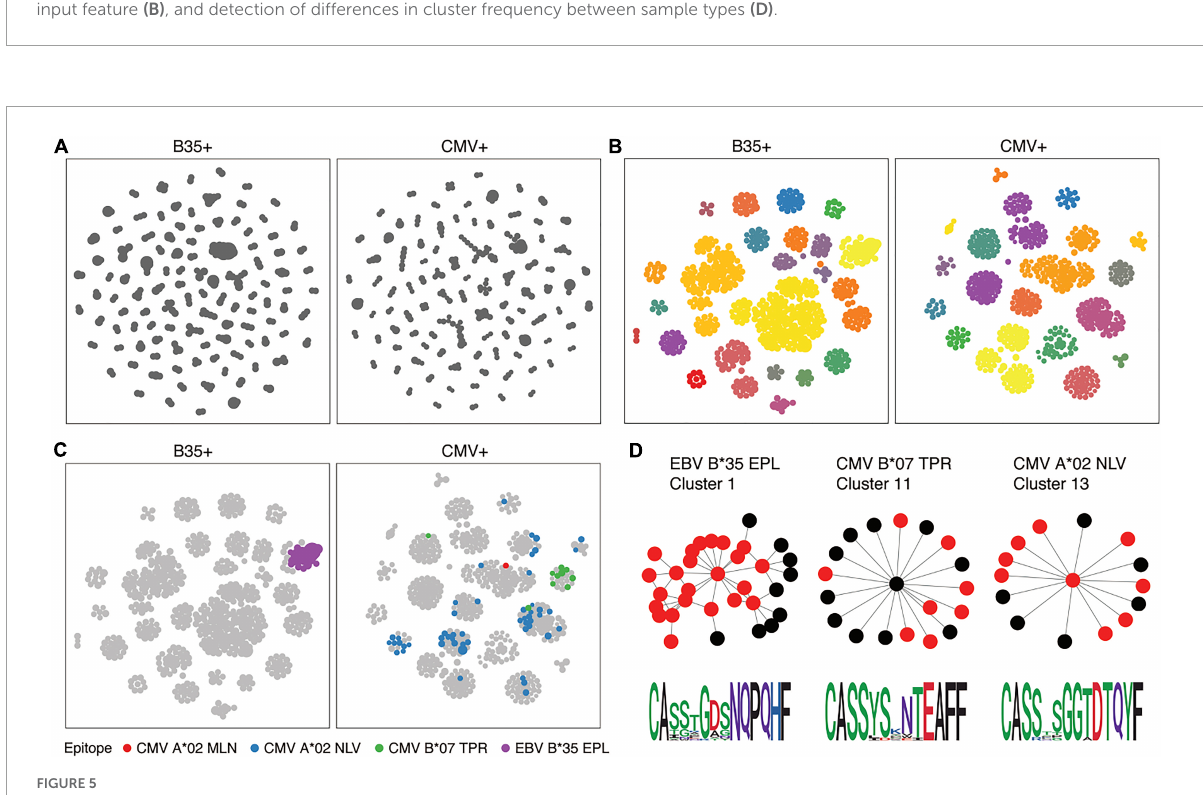
FIGURE5 T-cell receptor (TCR) similarity analysis (217). TCRs can be grouped in terms of sequence similarity (A) . Connected components can be identified by network analysis (B) . Known specificities can be overlaid on similarity networks (C) , and motifs inferred (D)